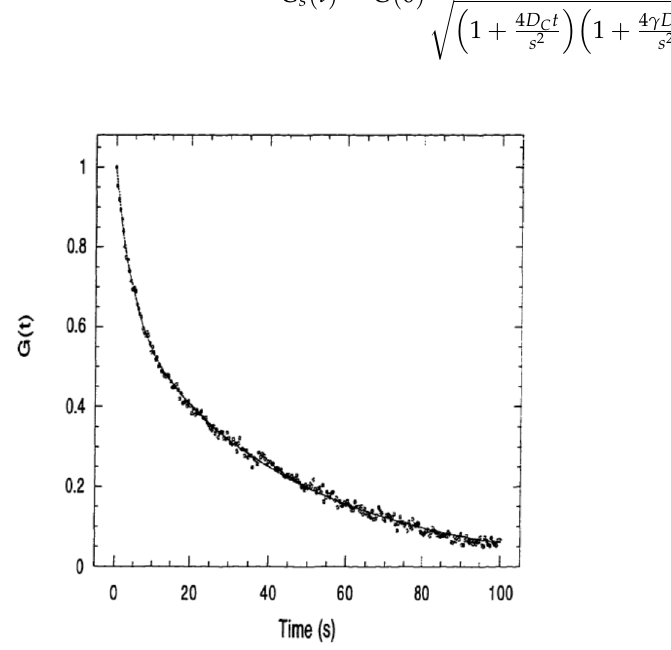
Figure 6. A conventional TIR/FRAP recovery curve ( F ( t ) vs. time) of fluorescently tagged DNA in PBS on amino-coated glass which was fitted with two adsorption state model (extended version of Equation (49)). Reprinted/adapted with permission from [96]. Copyright 1997, Vincent Chan.